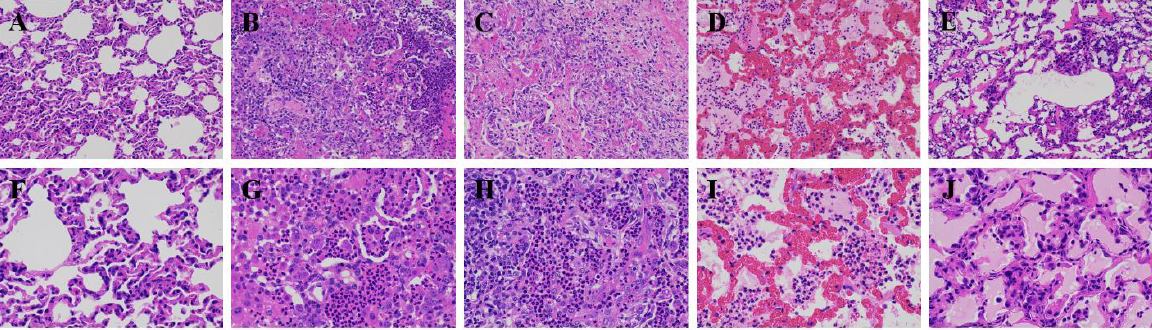
Figure 2. Histopathological analysis of lung lesions in the CK group ( A , F ) and after Pm infection 1 ( B , G ), 2 ( C , H ), 5 ( D , I ) and 7 ( F , J ) days. All the tissues were stained with hematoxylin and eosin. ( A – E ) Magnification, ×200; ( F – J ) Magnification, ×400; ( B , G ) The structural characteristics of the lung tissue were lost. The alveolar cavity was filled with inflammatory exudates, including neutrophils, monocytes and fibrin. ( C , H ) The structure of the alveolar wall was unclear; zccumulated neutrophils and macrophages were found in the alveolar cavity and some neutrophils degenerated and ne- crotized to form pus; lymphocyte aggregation can be seen in some areas of the alveoli. ( D , I ) The capillaries of the alveolar wall were highly ecchymosis and dilated. Neutrophils and edematous fluid accumulated in the alveolar cavity and red blood cells entered and presented in the alveolar cavity. ( F , J ) Alveolar wall thickened, alveolar epithelial cells swelled and proliferated; alveolar cavity was filled with a large amount of edema fluid, and in some of these areas there were macrophages and exfoliated and necrotic epithelial